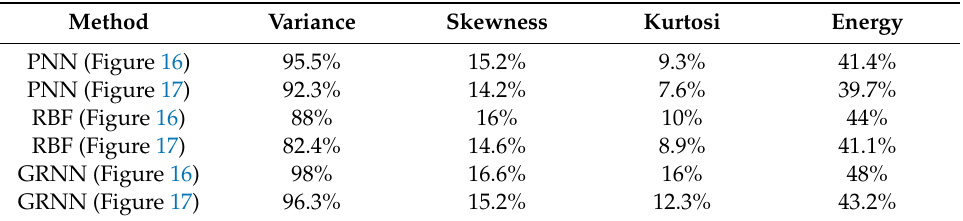
Table 1. Comparison among PNN, RBF and GRNN.